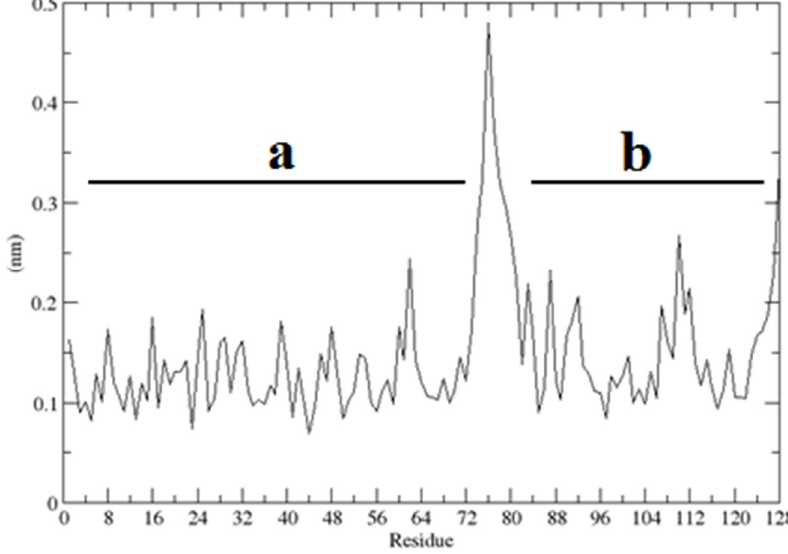
Figure 15. Mean RMSD fluctuations per residue of NEDD8 ( a ) and CUBAN ( b ) in the molecular dynamics simulation. Tracts with RMSD > 0.3 nm are located in the C-terminal end of NEDD8 and in the N-terminal end of CUBAN.